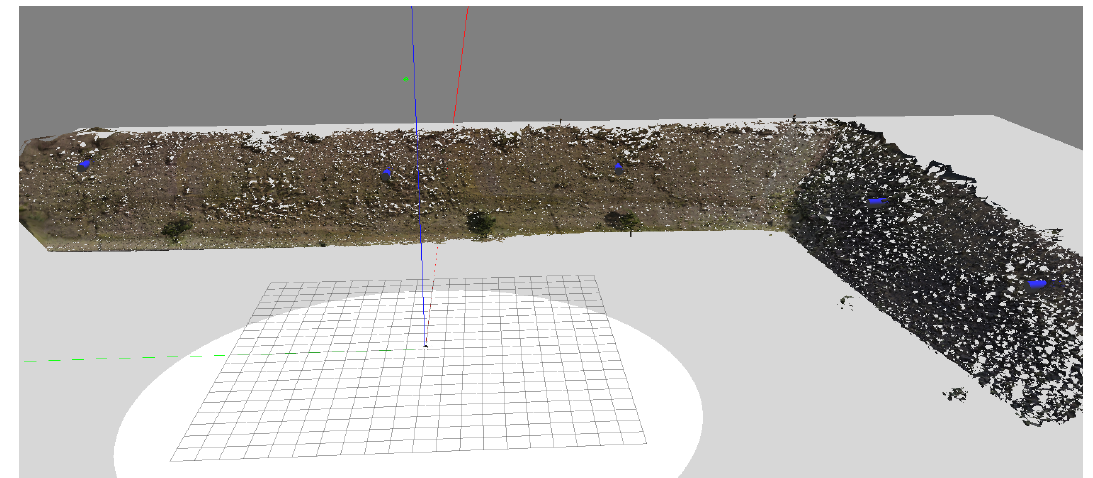
Figure 11. Gazebo World.